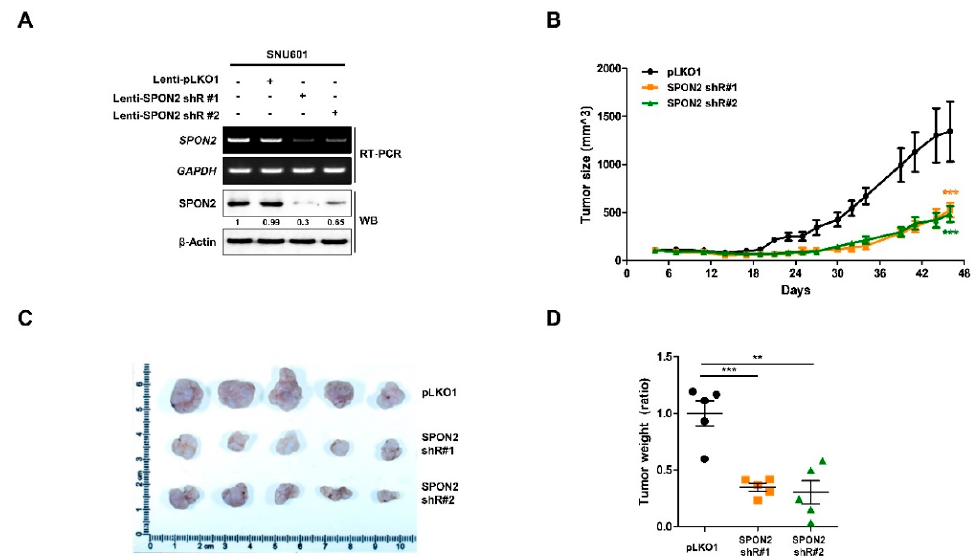
Figure 4. Effect of SPON2 inhibition on tumor growth in xenograft mice. ( A ) Stable SPON2 -silenced SNU-601 cells were generated by lentivirus infection containing SPON2 -specific shRNA #1 or shRNA #2. Lentivirus expressing pLKO1_E.V was used as control. Following infection, decreased SPON2 expression levels were detected by RT-PCR and Western blot analysis. ( B ) Stable SPON2 -silenced cells (50 µL, 2 × 10 6 cells) with matrigel were implanted in Balb/c nude mice to generate xenografted mice model (each group of pLKO1, SPON2 shR#1, and SPON2 shR#2, n = 5). Tumor sizes were measured three times per week until sacrificed at day 47. ( C,D ) Xenograft tumors were isolated from the sacrificed mice at day 47. ( C ) Resected tumor was fixed with formaldehyde and visualized using documented immunostaining method. ( D ) 5 Tumors of each group were quantified using microbalance and histogram were developed. p -values were calculated using Student’s t -test, and significant differences are indicated by * (** p < 0.01, *** p < 0.001).